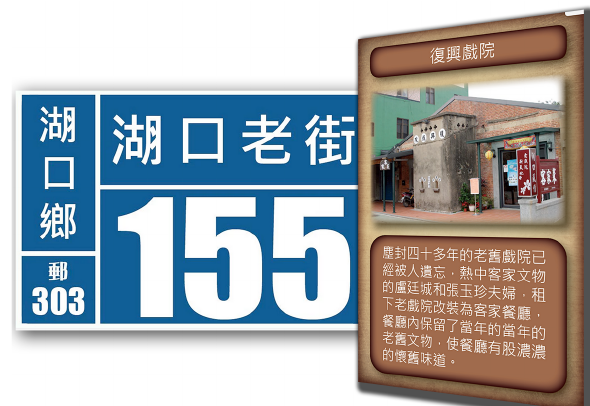
Figure 6. Scanning the door plate (left, the rear side of the board game card) to show further information about the building (right)